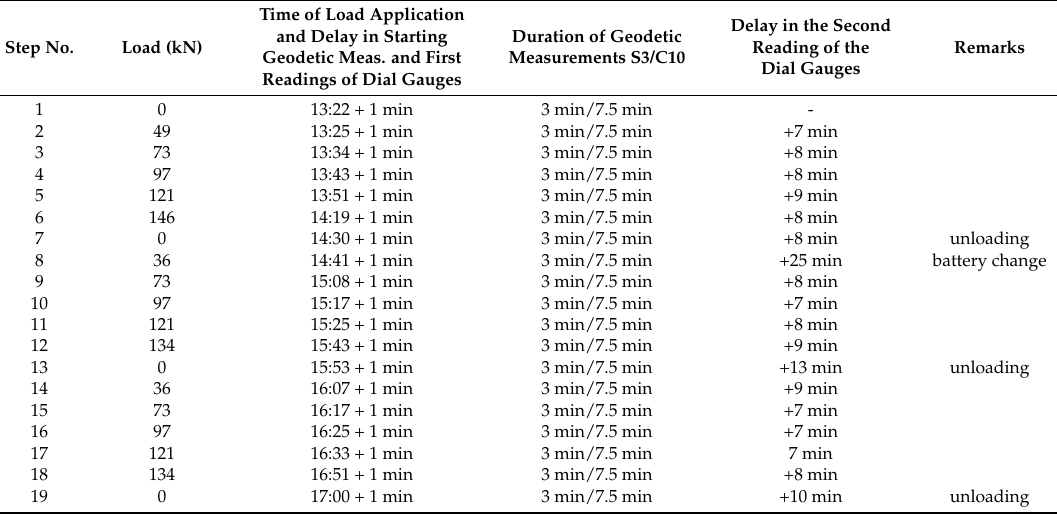
Table 1. The time schedule of the performed